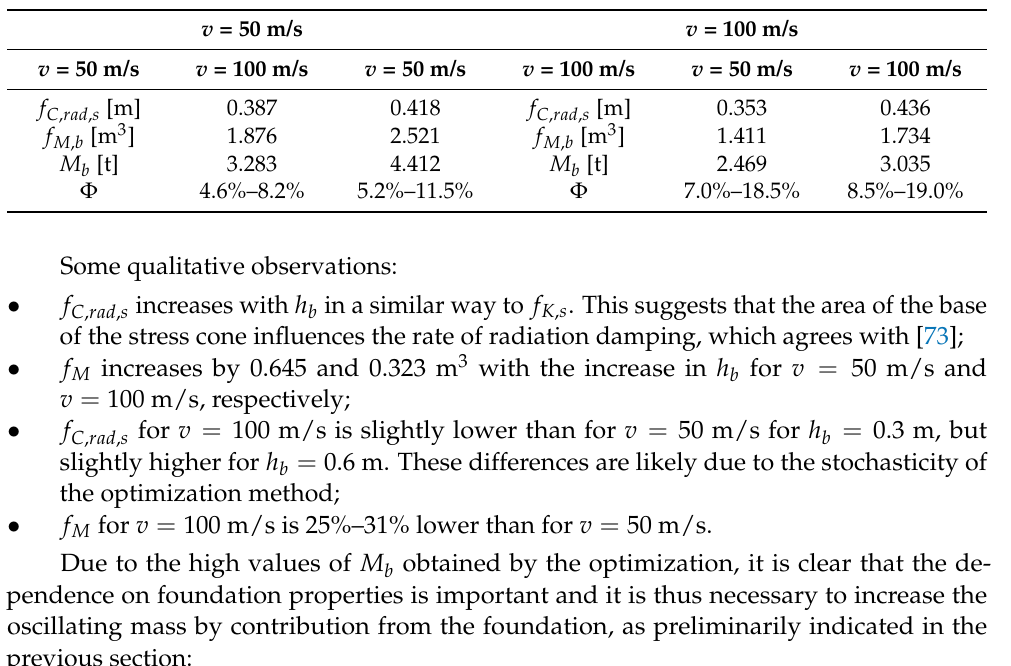
Table 3. Optimum values for the dynamic case in combined